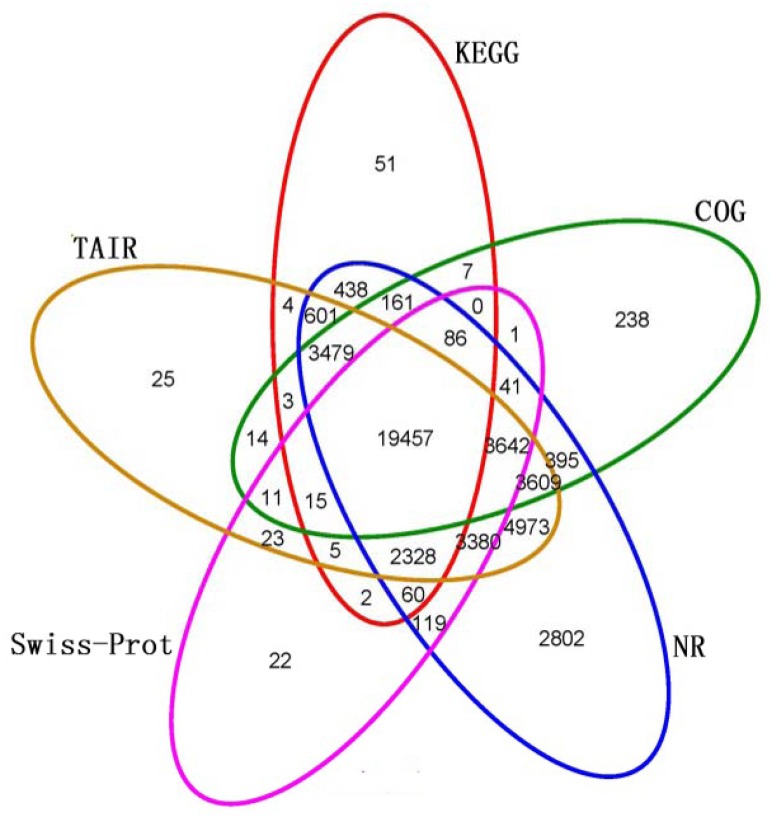
Venn diagram showing BLAST results of Camellia sinensis transcriptome against five databases.De novo reconstructed transcript sequences were used in BLAST searches against public databases: KEGG, COG, NR, Swiss-Prot, and TAIR. Number of unigenes with significant hits (E-value ≤10−5) against five databases is shown at each intersection of Venn diagram.